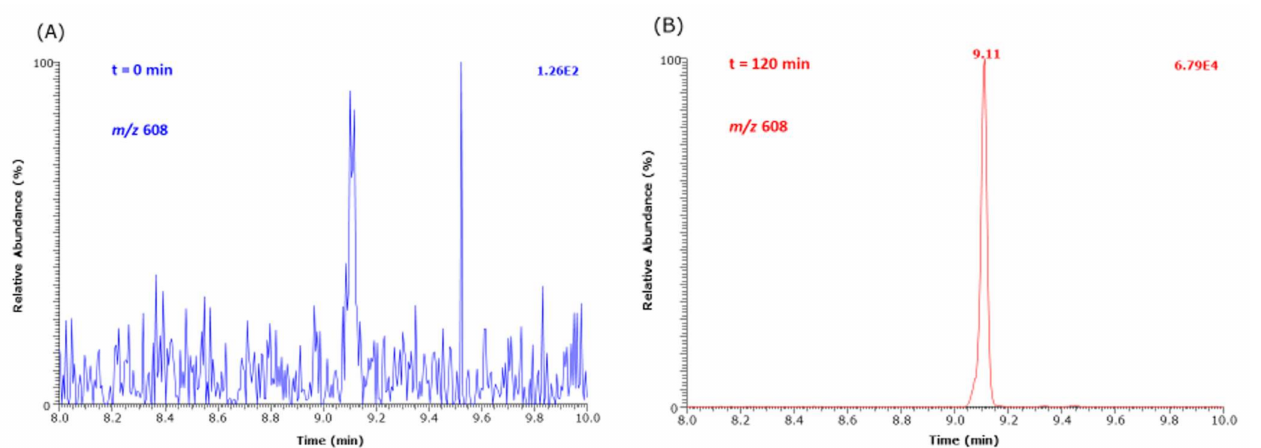
Figure 7. Partial GC-MS chromatograms of selected ion monitoring of m / z 608 of the Me-PFP derivative of HML formed from the reaction of 1 mM Lys methyl ester with 5.8 mM MGO at 37 ◦ C in 100 mM buffer, pH 7.4, ( A ) before addition (t = 0 min) and ( B ) after addition (t = 120 min) of